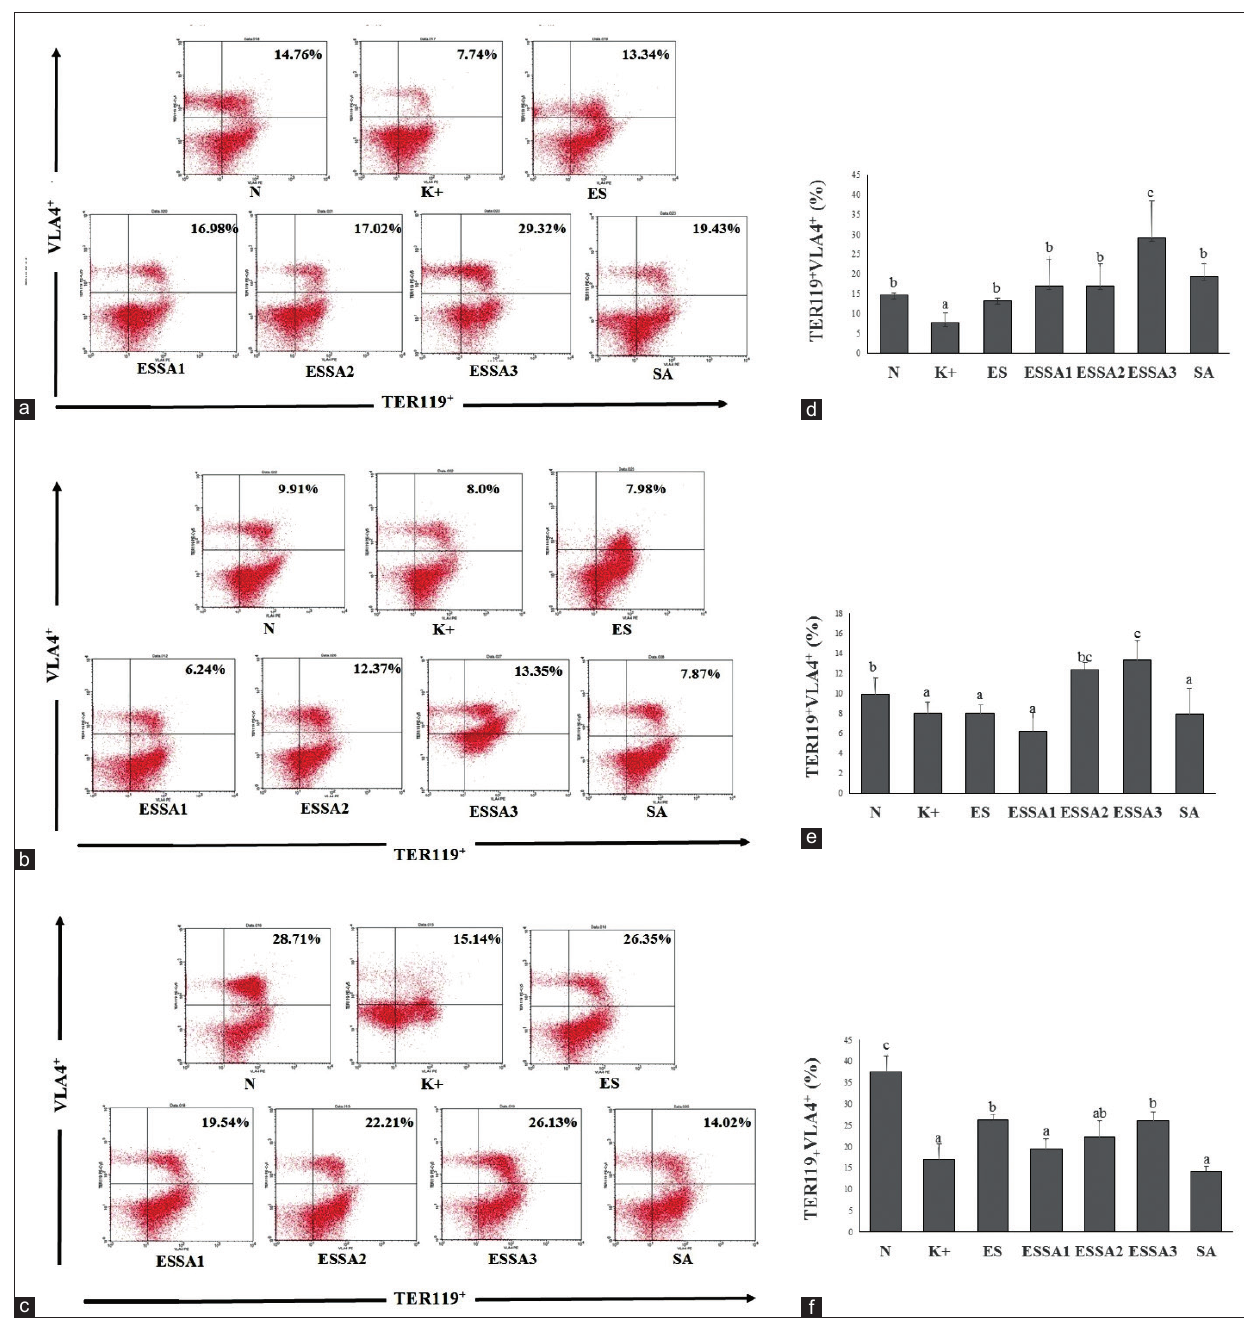
Figure-1: Flow cytometry of isolated bone marrow labeled with TER-119 + VLA + post- Escherichia coli challenge. (a-c) Representative FACS dot plots showing the percentage of TER-119 + VLA + in all groups treatment on day-8, 12, and 16, respectively. (d-f) The bars are a calculation of the relative number TER-119 + VLA + expression on day-8, 12, and 16, respectively. The results were expressed as the mean±SD. Different superscript letters indicate statistical significance (p<0.05). Note: Healthy pregnant mice were not subjected to E. coli infection ( N ), pregnant mice infected with E. coli ( K+ ), pregnant mice infected with E. coli and treated with 200 mg/kg of ES ( ES ), pregnant mice infected with E. coli and treated with combined 150 mg/kg ES and 37.5 mg/kg SA (75% ES:25% SA), 100 mg/kg ES and 75 mg/kg SA (50% ES:50% SA), and 50 mg/kg ES and 112.5 mg/kg SA (25% ES:75% SA) ( ESSA1, ESSA2, and ESSA3, respectively), and pregnant mice infected with E. coli and treated with 150 mg/kg SA ( SA